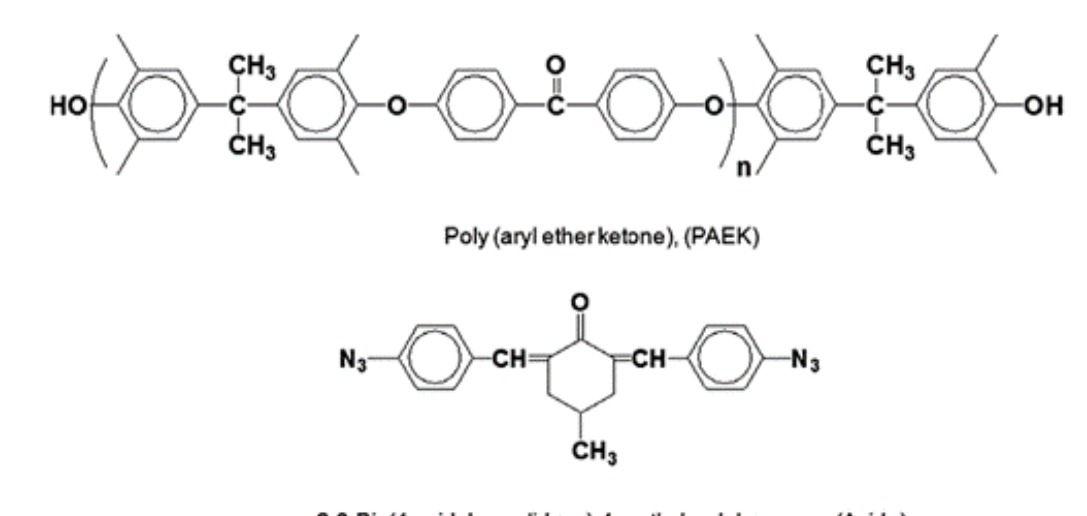
Figure 14. Chemical structures of PAEK and Azide. Adapted from [113] with permission. Copyright (2009) Elsevier.